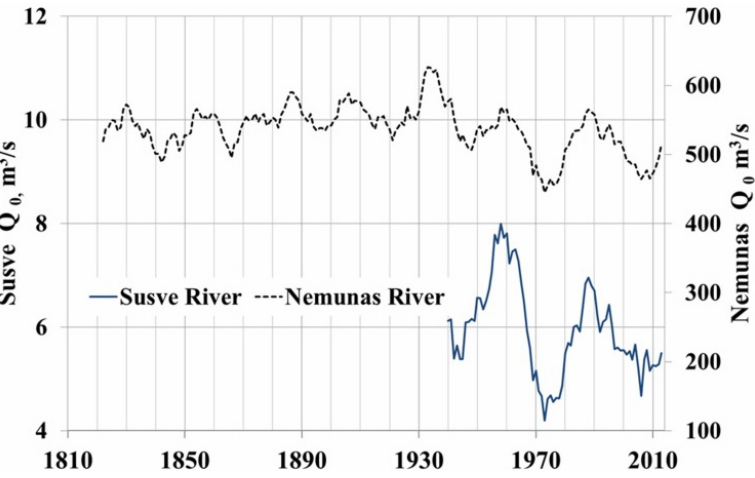
Figure 3. 11-year moving average flow ( Q o ) graphs for the Susve River at Josvainiai and the Nemunas River at